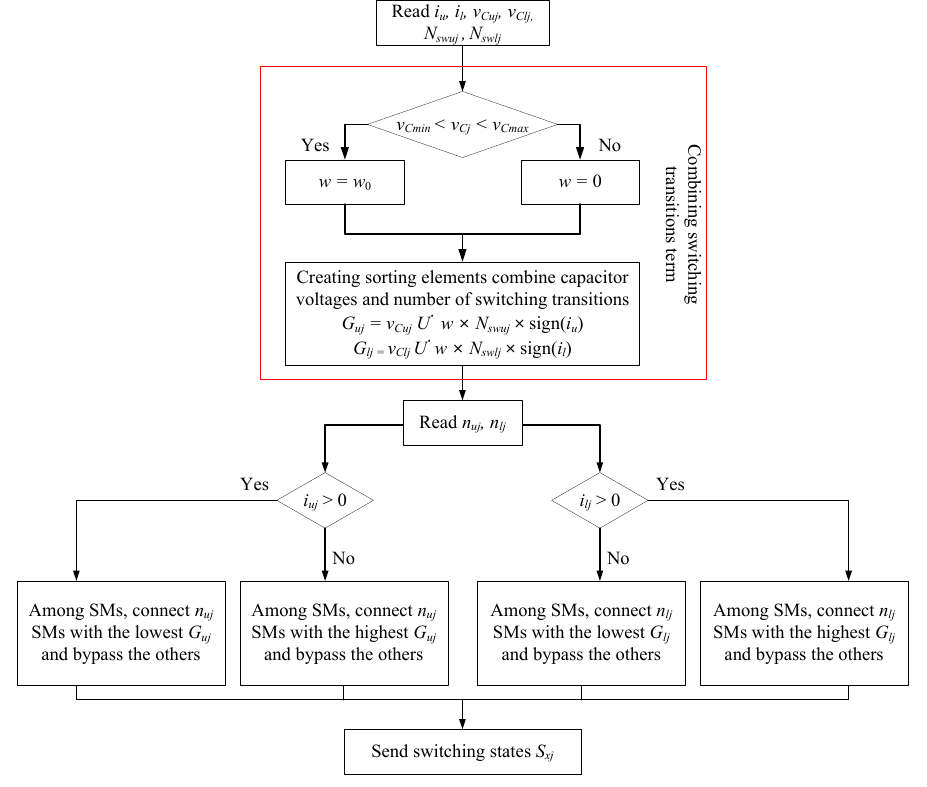
Figure 4. Proposed switching loss balancing control strategy-based capacitor voltage sorting algorithm.